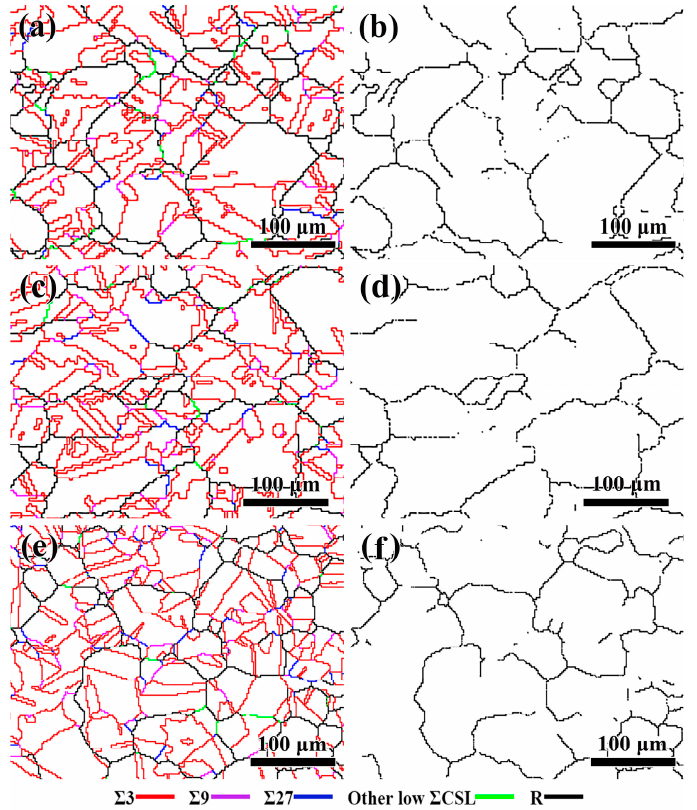
Figure 5. GBCD and corresponding RHAGB network maps of the GBE samples: ( a , b ) Ni-5at.%Cr; ( c , d ) Ni-20at.%Cr; ( e , f ) Ni-40at.%Cr. ( c , d ) Ni-20at.%Cr; ( e , f )